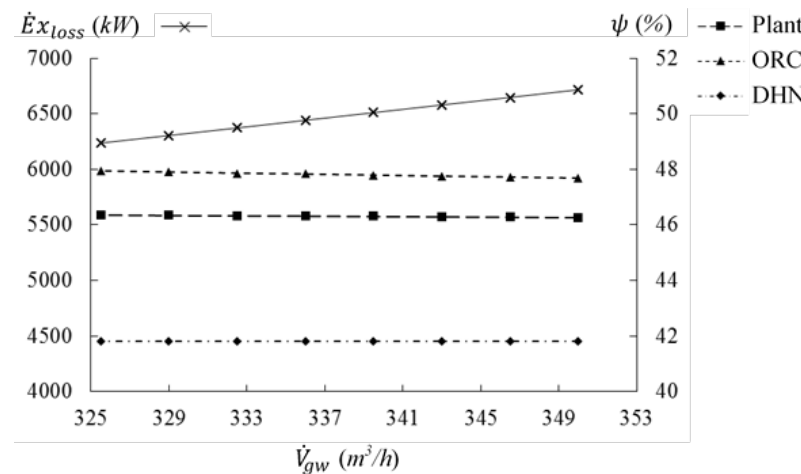
Figure 8. Evolution of 𝐸̇𝑥 𝑙𝑜𝑠𝑠 , 𝜓 𝑂𝑅𝐶 , 𝜓 𝐷𝐻𝑁 , and 𝜓 𝑝𝑙𝑎𝑛𝑡 with the flow rate of the geothermal source.